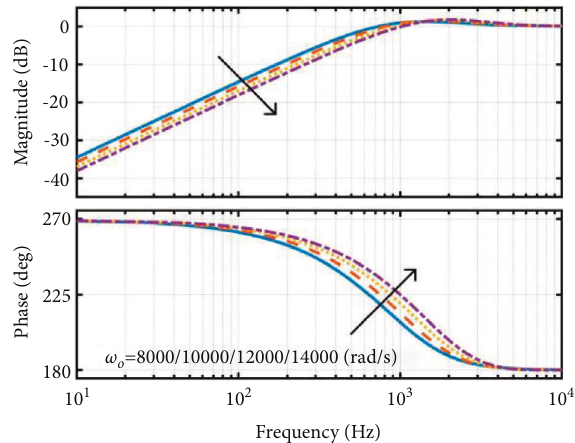
Figure 4: Phase-frequency characteristics of x